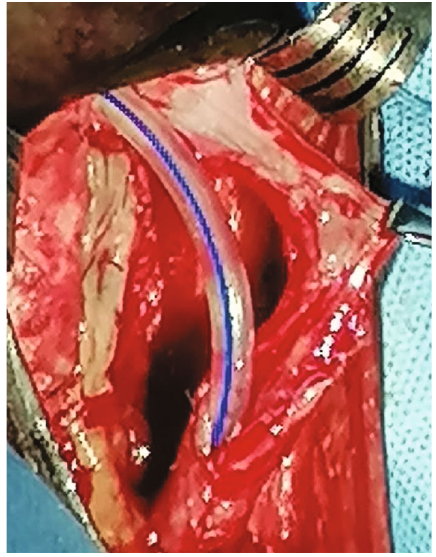
Figure 6: The narrowed urethral segment has been opened up under direct vision, and the oral mucosa graft has been quilted to the underside of the corporeal bodies.